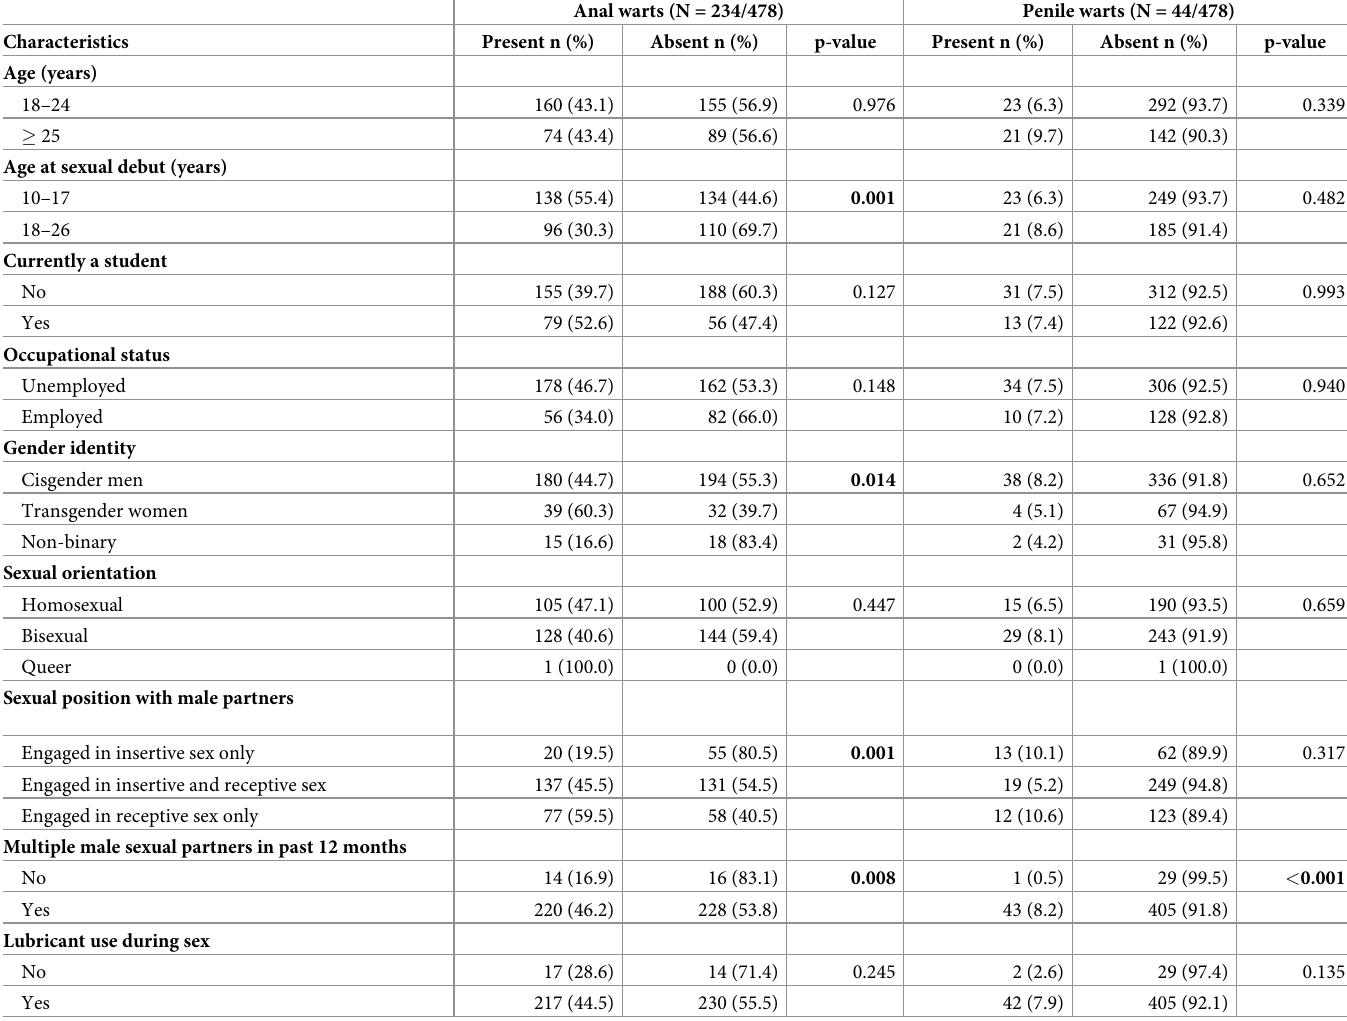
Table 2. Anal and penile warts sexual risk behaviors by key socio-demographics and sexual risk behaviors